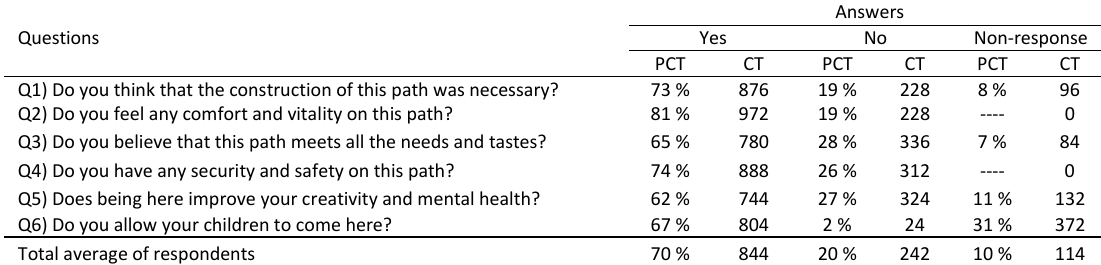
Fig. 12: (a) Percentage of respondents by age; (b) Percentage of respondents by gender Table 3: Frequency percentages and counts for the number of respondents based on questions and their answers